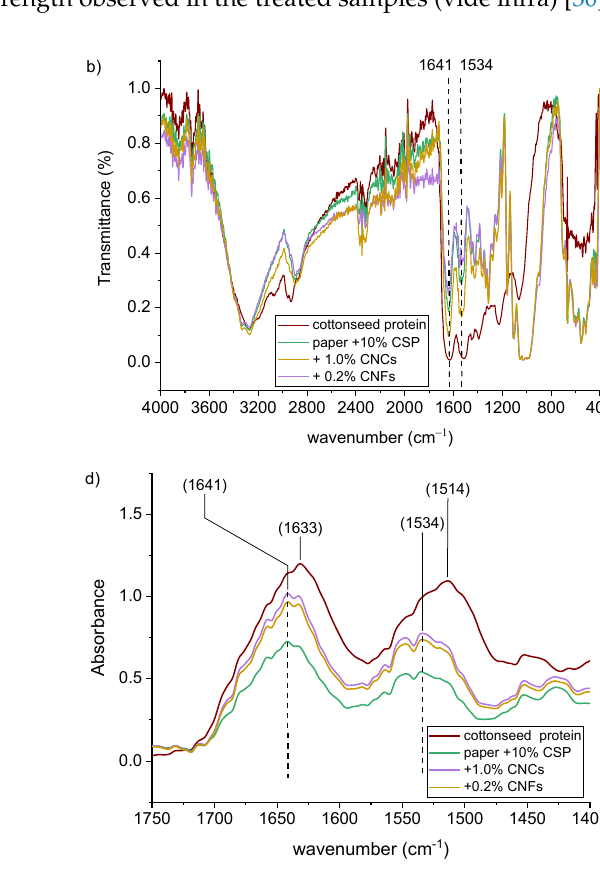
Figure 3. FTIR transmittances spectra of ( a ) paper and control paper sample rinsed with water, treated with pH 10 water, and nanocellulose dispersions; ( b ) FTIR transmittance spectra of cottonseed protein isolate and paper samples treated with cottonseed protein or cottonseed protein and nanocellulose; ( c ) expansion of the cellulosic region from 1600 cm −1 to 750 cm −1 from ( a ); ( d ) FTIR absorbance spectra of the region about the amide bonds (1750 cm −1 to 1400 cm −1 ) from ( b ). Examination of the SEM micrographs (Figure 4) indicates a loose network of ran- domly distributed fibers for the filter paper structure with numerous void spaces. The